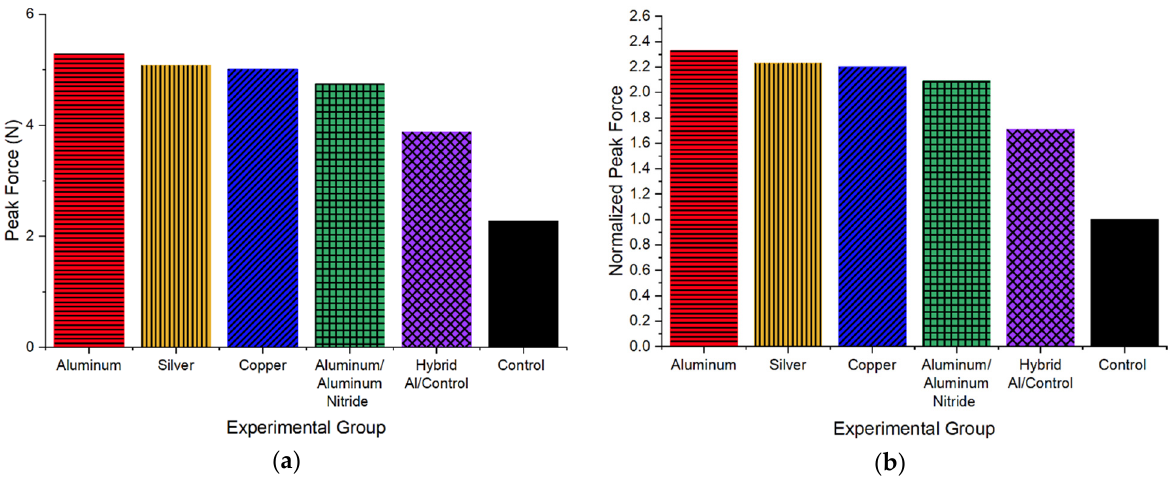
Figure 11. Peak pull ‐ out force at 200 N transverse pre ‐ tension ( a ) peak force ( b ) normalized peak pull ‐ out force with respect to control.